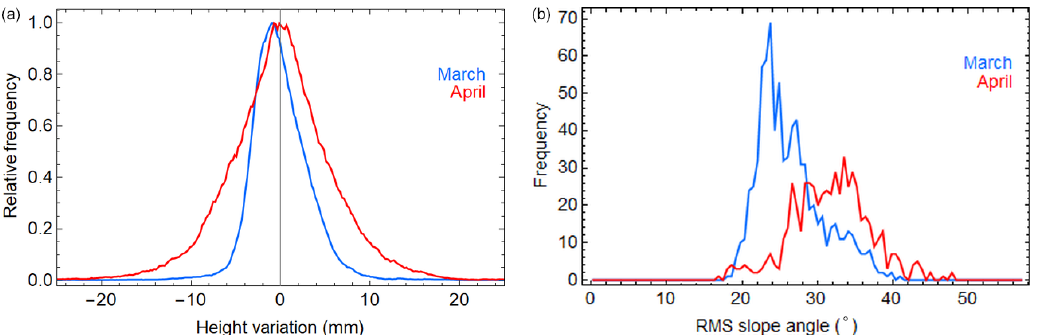
Figure 4. Surface characteristics calculated from the plate measurements in March and April. (a) The relative height distributions and (b) the distributions of the slope angles (in degrees) at the average measured spatial resolution of